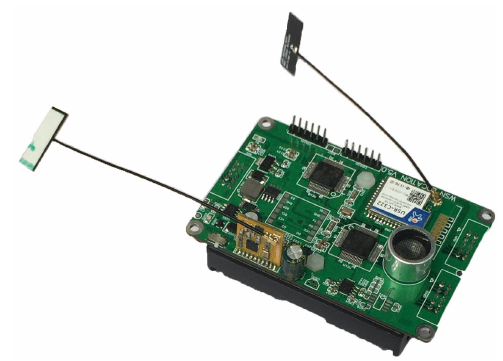
Figure 7. The photo of the UIPS